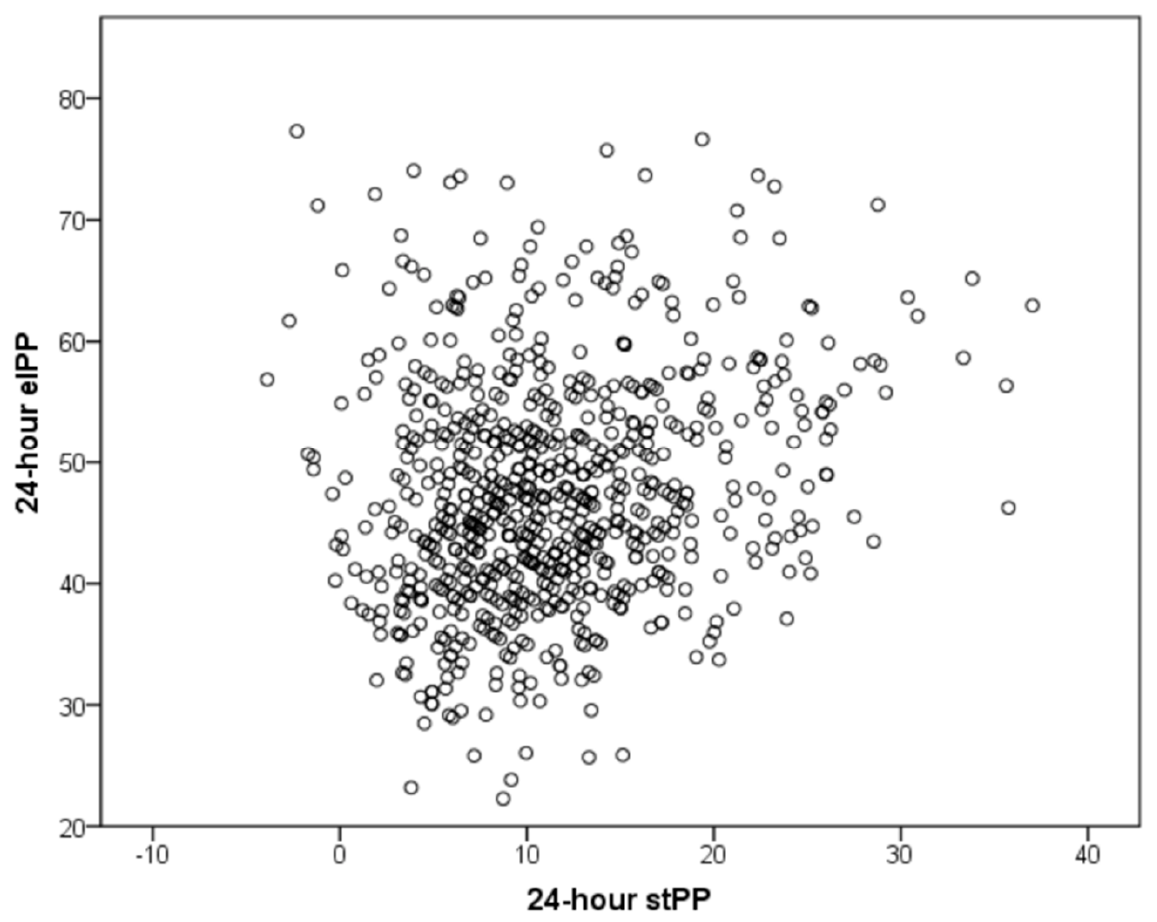
Figure 2. Correlation between 24-hour elastic pulse pressure (elPP) and stiffening pulse pressure (stPP) in the study population.